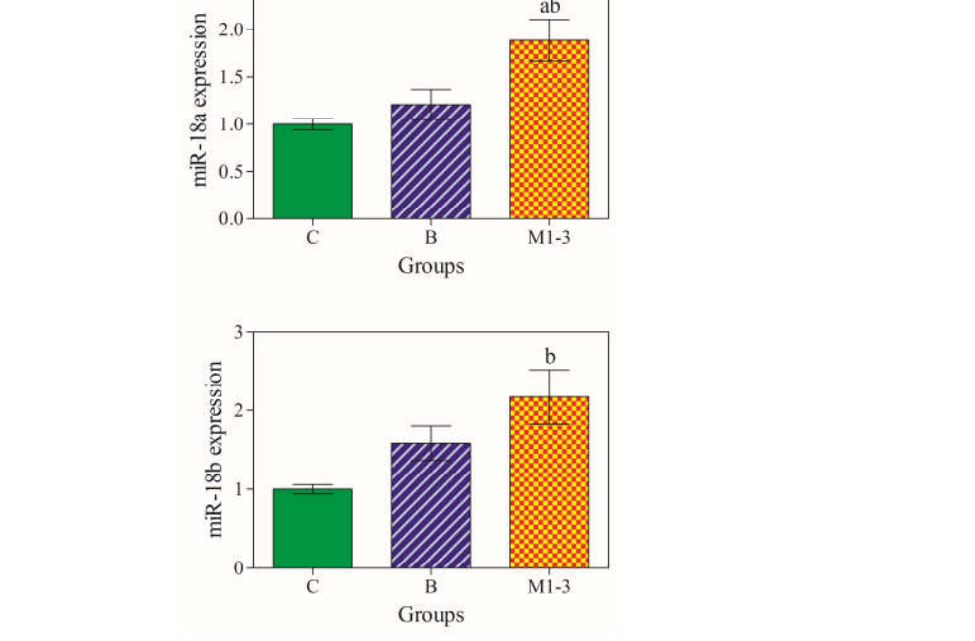
Figure 2. Expression levels of miRNAs in mammary samples. miR-18a was overexpressed in malignant tumors (M1–3; orange color) compared with the control group (C; green color) and benign tumors (B; blue color), whereas miR-18b was overexpressed in malignant tumors (M1–3) compared with the benign tumors (B). Significances ( p < 0.05) a vs. Group C and b vs. Group B.